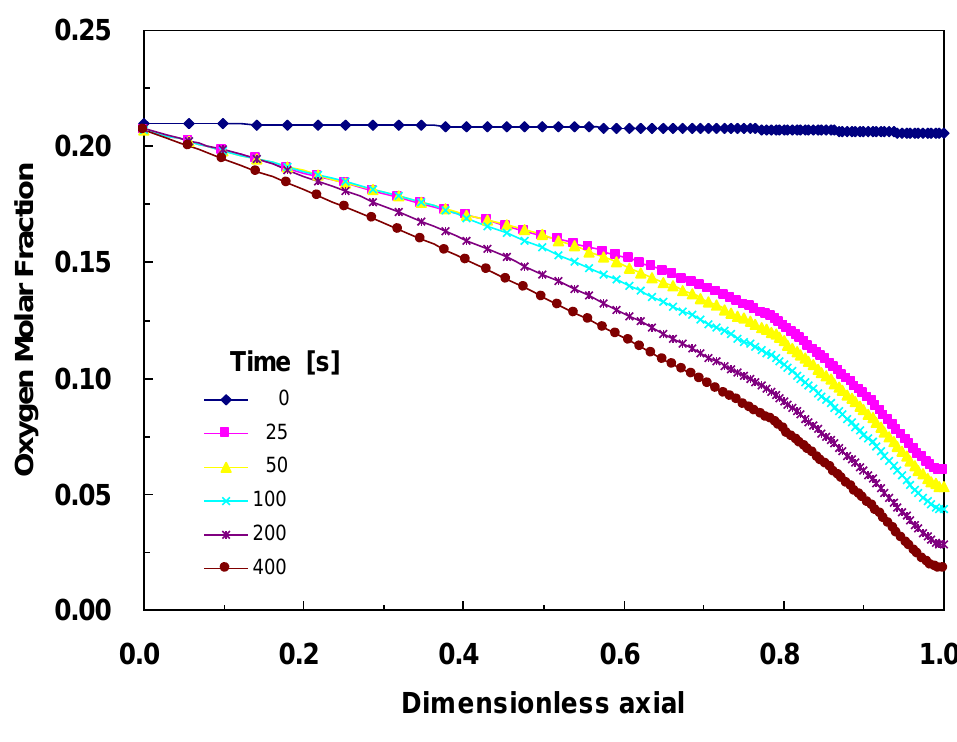
Figure 7. Distribution profile of oxygen molar fraction during a step change of potential from 0.9 V to 0.4